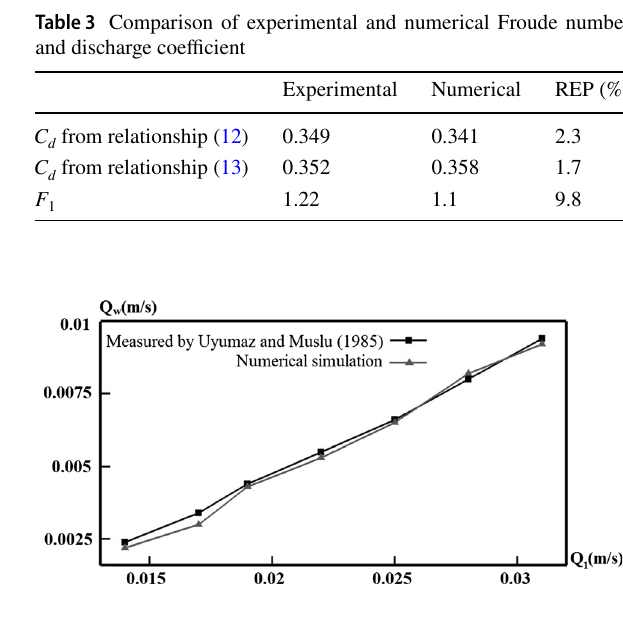
Fig. 4 Comparison between free surface changes of numerical and experimental models